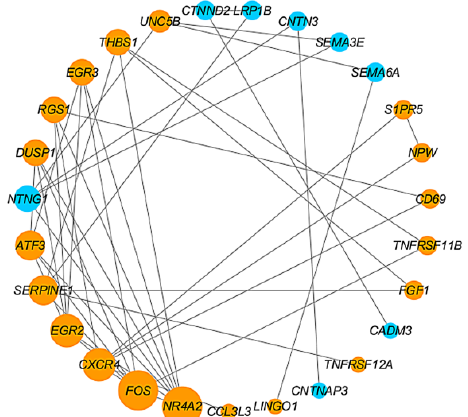
Figure 5. PPI network and hub genes. Size of the diameter represents the degree of the genes in the process of hub gene identification. The blue points indicate downregulated genes, and orange points indicate upregulated genes. PPI: protein – protein interaction.